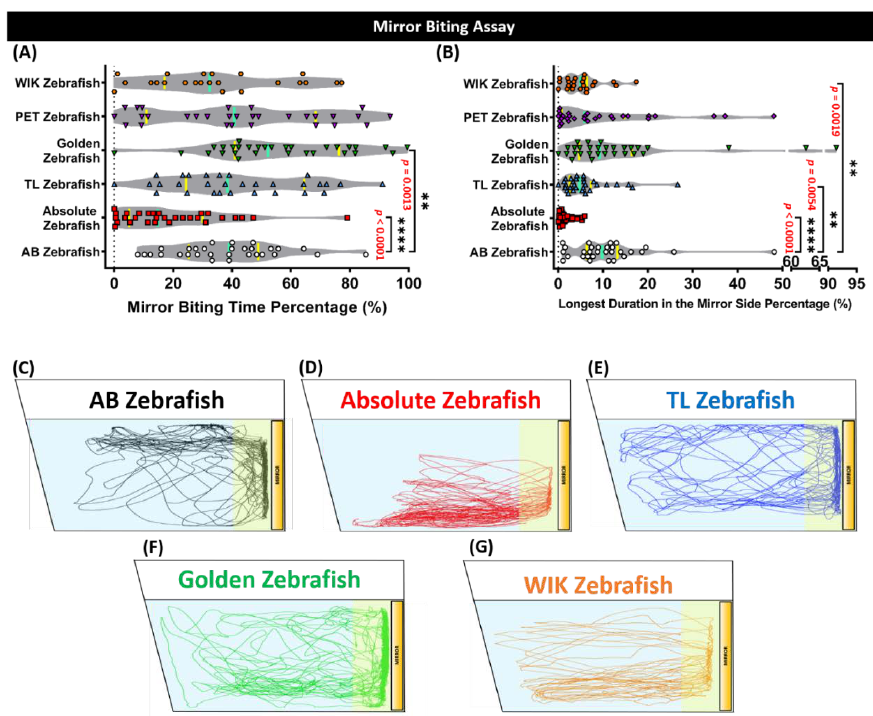
Figure 2. Mirror-biting behavior endpoint comparisons between the AB zebrafish (white), absolute zebrafish (red), TL (Tübingen Long Fin) zebrafish (blue), golden zebrafish (green), PET (Pet Store-purchased) zebrafish (purple), and the WIK (Wild Indian Karyotype) zebrafish (orange). ( A ) Mirror-biting time percentage and ( B ) the longest duration in the mirror side percentage were analyzed for the mirror-biting assay. The median and the interquartile for the violin plot were labeled with the bold line colored with cyan and yellow, respectively. The 5 min locomotor trajectories for the AB, absolute, TL, golden, and the WIK zebrafishes are presented in ( C – G ), respectively, with the yellow-colored zone as the mirror-biting region. The data were analyzed by a Mann–Whitney test ( n = 30 for each group, except for the WIK zebrafish ( n = 23); ** p < 0.01; **** p <